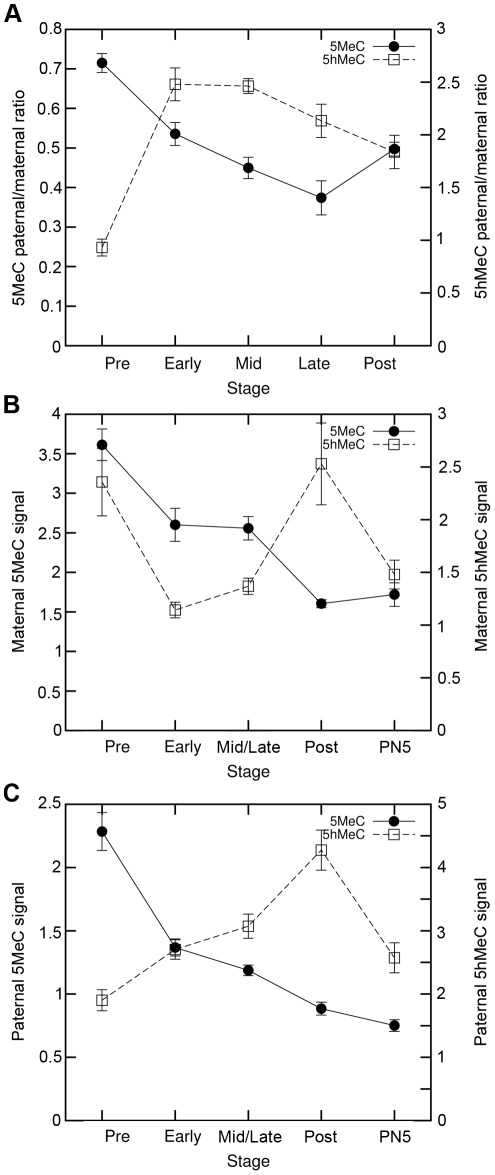
Quantification of 5MeC and 5hMeC over the replication period.Quantification of the global 5MeC and 5hMeC signal was performed and corrected for background and DNA content as described in Material and Methods. A) Comparison of the paternal/maternal ratios obtained for 5MeC and 5hMeC from pre-replication to post-replication. 10 to 27 embryos were quantified for each stage. B) Comparison of 5MeC and 5hMeC dynamics in the maternal pronucleus. Respectively 21 to 46 embryos and 10 to 27 embryos were quantified for each stage. C) Comparison of 5MeC and 5hMeC dynamics in the paternal pronucleus. Respectively 21 to 46 embryos and 10 to 27 embryos were quantified for each stage. Note that different scales were used on all panels for 5MeC and 5hMeC quantifications.